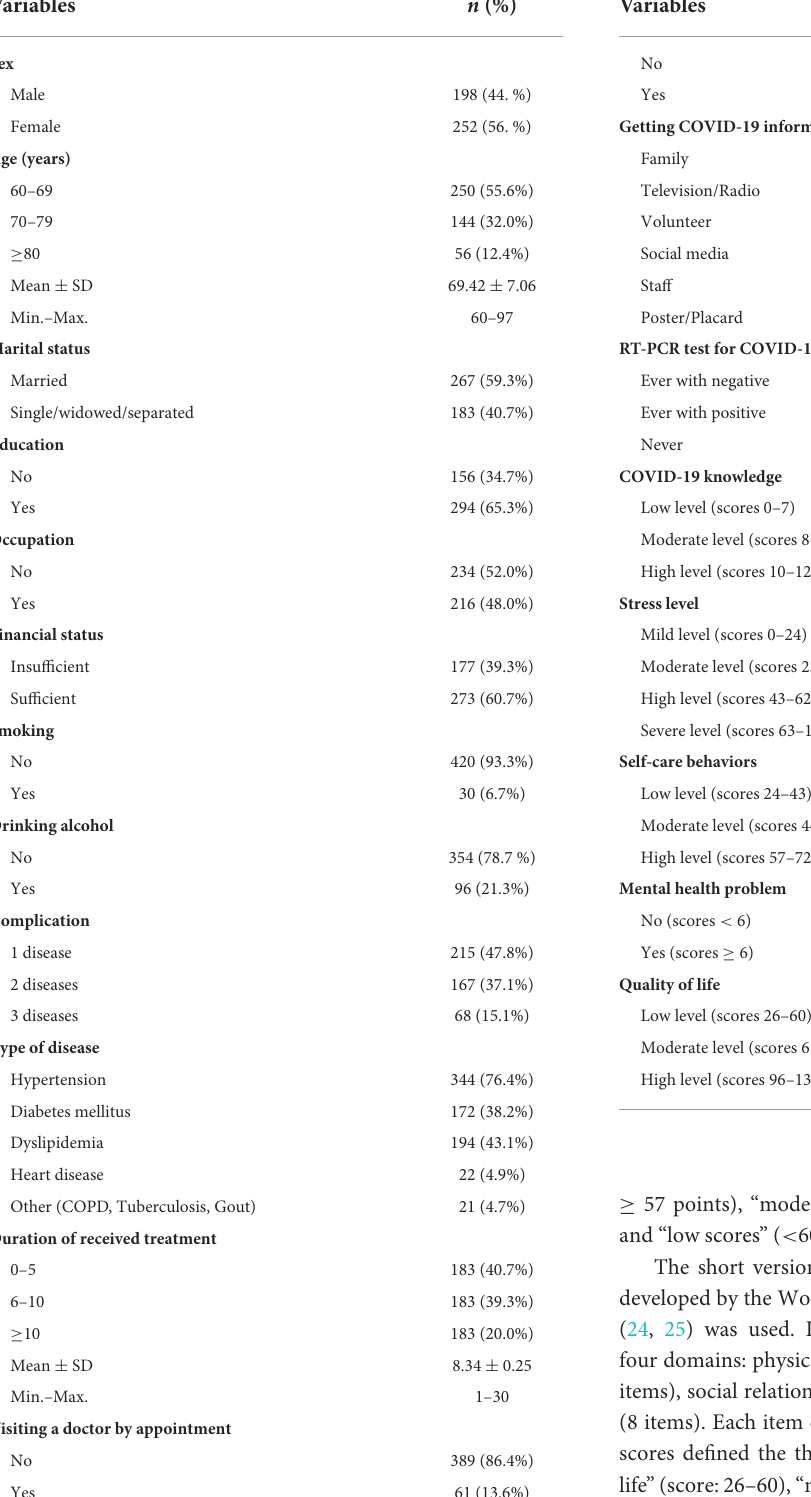
TABLE 1 General characteristics of participants ( n =